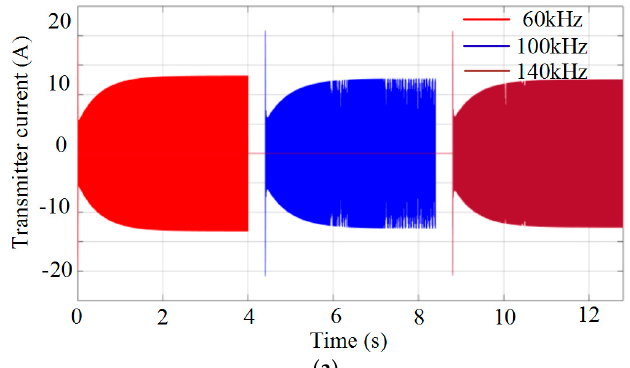
Figure 5. Electromagnetic field analysis at resonant frequency of 140 kHz: ( a ) magnetic flux line distribution; and ( b ) magnetic flux density distribution.